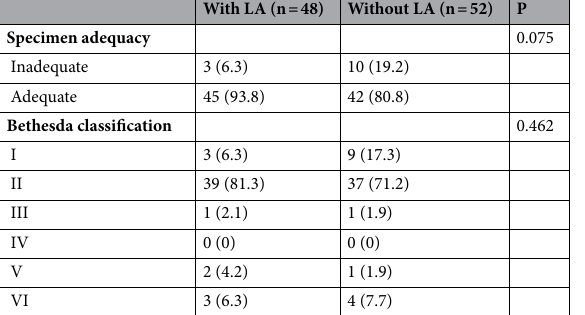
With LA (n = 48) Without LA (n = 52) P Specimen adequacy